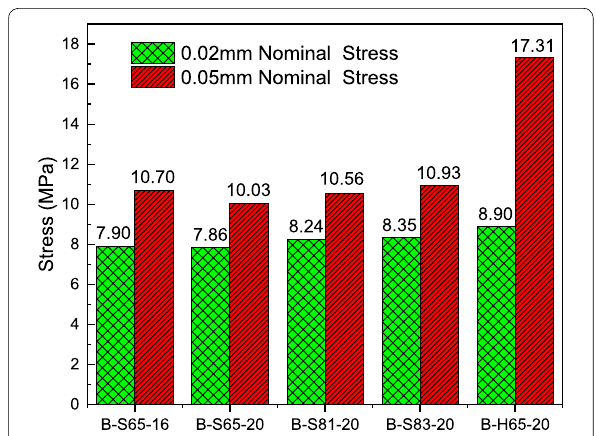
Fig. 16 Nominal stresses of the specimens with 0.02 mm and 0.05 mm crack